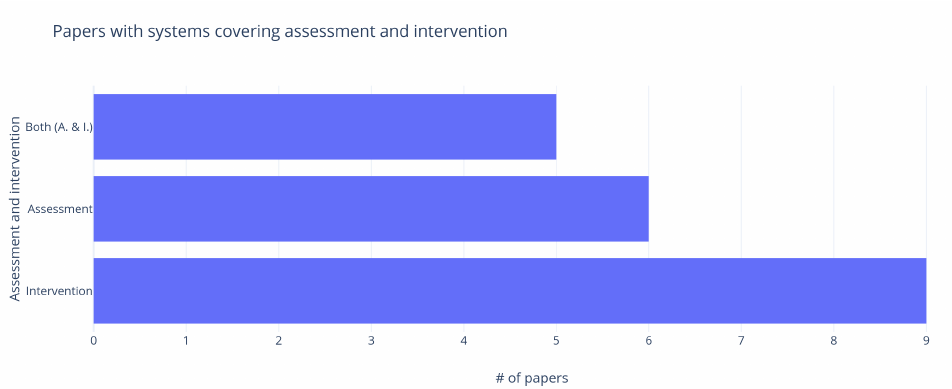
Figure 9. Papers with systems covering assessment and intervention.